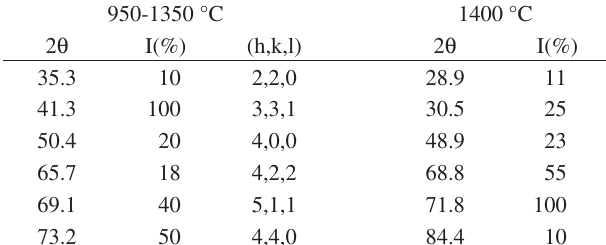
Table 1. Data from X ray diffraction patterns of Co-Zn ferrites sintered at different temperatures.